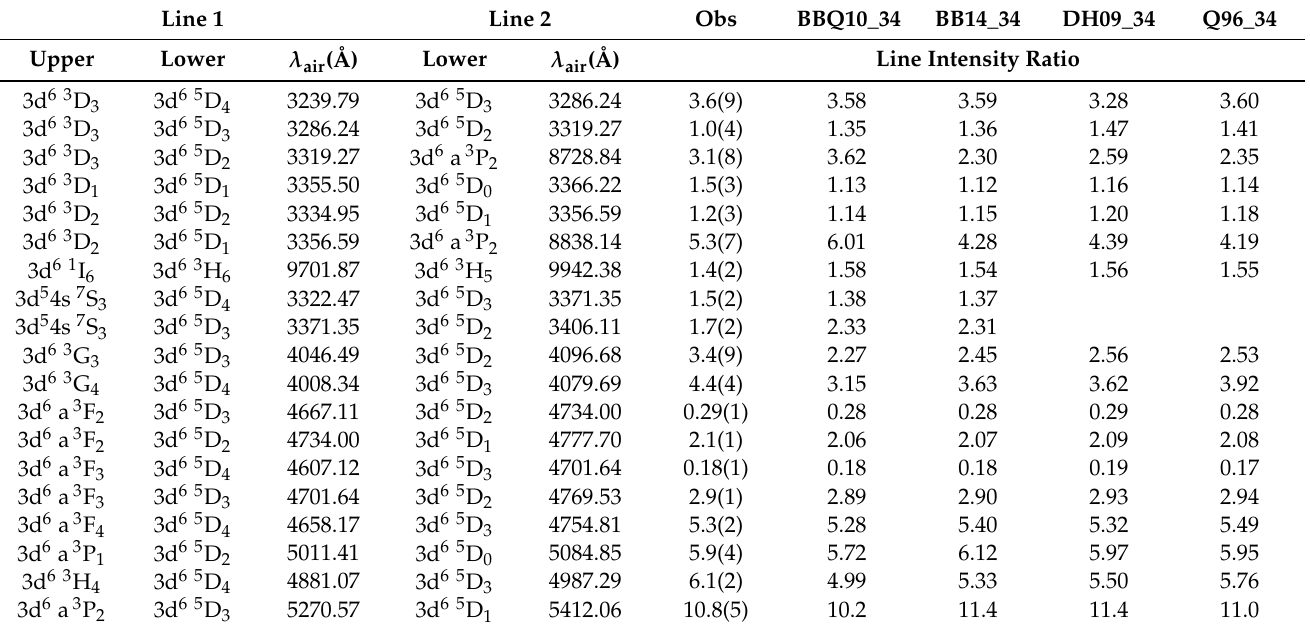
Table 3. Comparison of observed [Fe III ] line intensity ratios in HH204 (Obs) for transitions sharing a common upper level with those estimated from A -values in the BBQ10_34, BB14_34, DH09_34, and Q96_34 atom files. The error of the least significant figure of the observed intensity ratio is indicated in